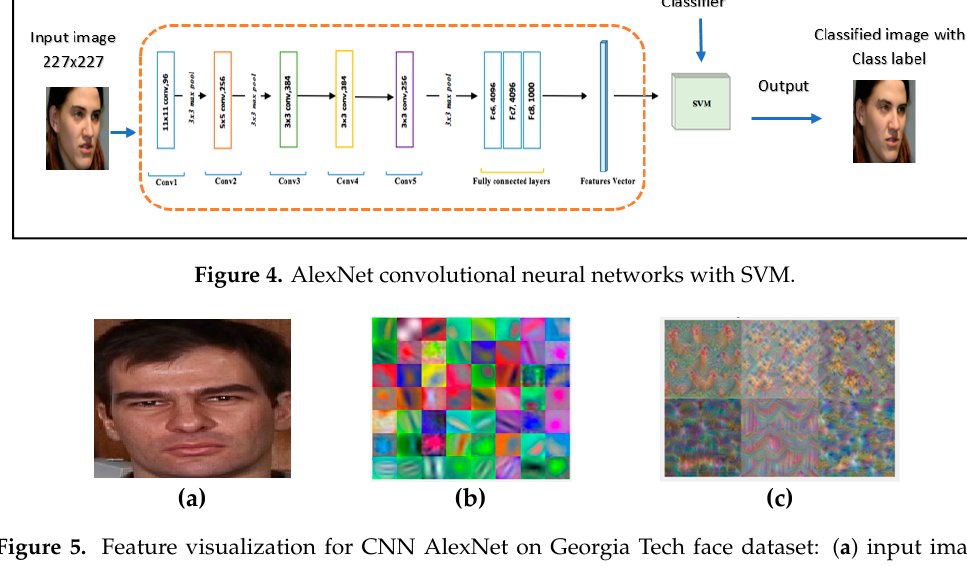
Figure 6. Recognition accuracy for AlexNet with features from layers ‘fc6’, ‘fc7’, and ‘fc8’. 4.2.2. Second Experiment: Pre-Trained ResNet-50 Model with SVM The learned image features from the training images were extracted and followed by SVM classifier, as shown in Figure 7. In the implementation process, we created an Image-Data store to help with data management. This was because, after reading, the images were loaded into the memory system, thus making it effective for a huge collection of images. After uploading, the data were divided into 70% training and 30% validation using random sampling to avoid biasing the results. As a pre-processing stage, ResNet-50 network can only process RGB images that are 224 × 224; here, we resized and convert any grayscale images to RGB. Using deep layers for higher level features gives better distinct features for recognition tasks. For feature extraction, the layer before classification layer, named ‘fc1000’, was used to extract features by using the activation method. These features were then used to train and test SVM classifiers using a fast-linear solver. The activation outputs were arranged into columns to speed-up SVM training that follows, and the fast stochastic gradient descent (SGD) was implemented for the training. The 'MiniBatchSize' was set 32 .